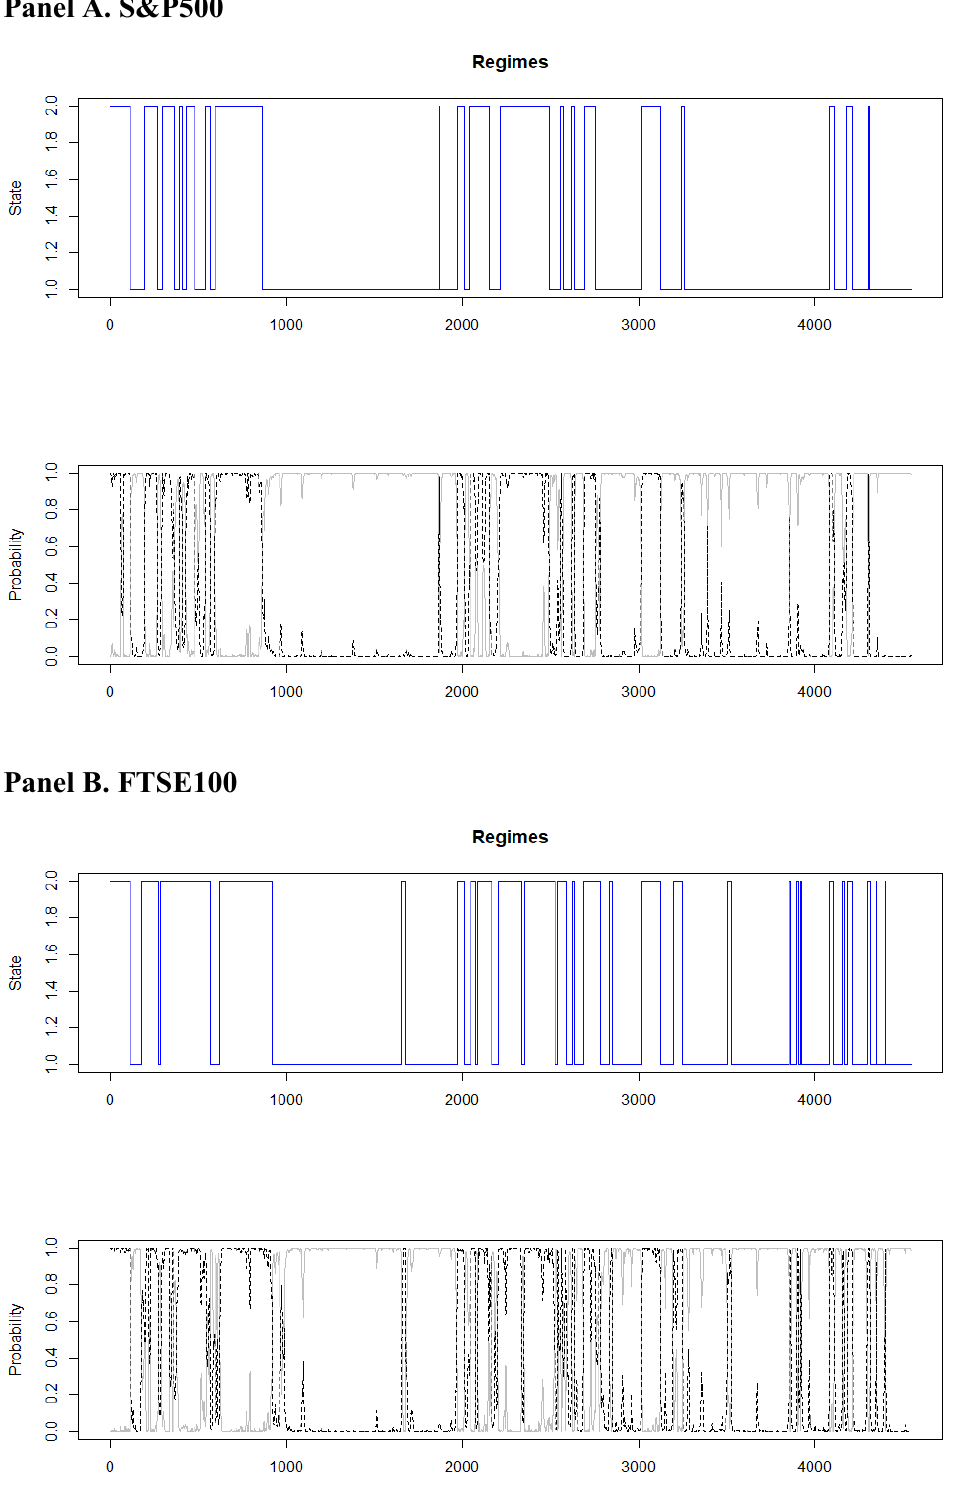
Figure 5. Defined volatility regimes. Note : This set figures depicts the volatility regimes in returns (upper figure) and the probability of the high and low volatility regimes (bottom figure) of S&P500 and FTSE100 indices. On the bottom figure, the grey color refers to high volatility regimes while the black color refers to low volatility regimes. Panel A refers to S&P500 index sample. Panel B refers to FTSE100 index sample.